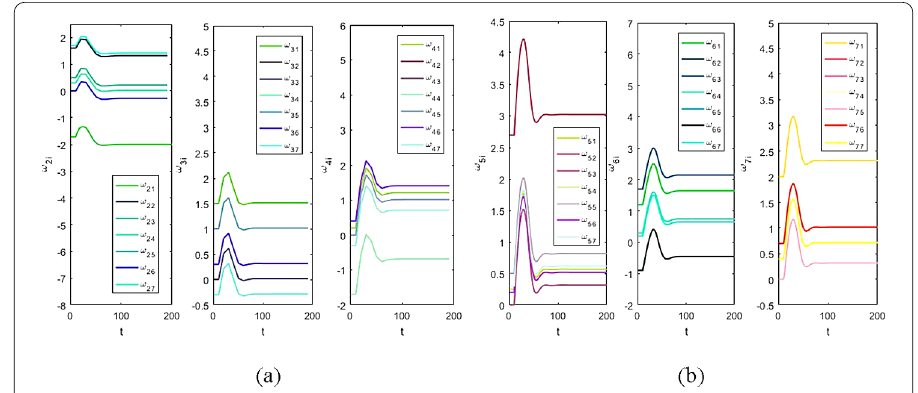
Figure 3 Identification process for the uncertain parameters ω ij ( i = 2, ... ,7; j = 1, ... ,7)